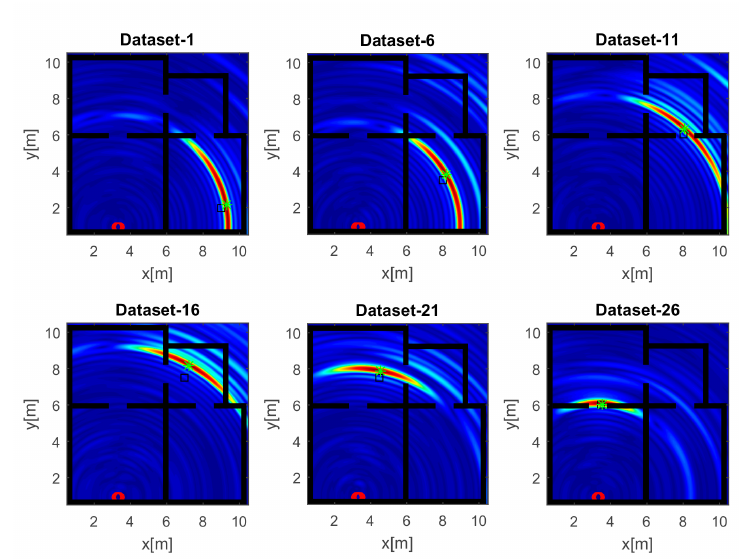
Figure 7. Tomographic images of a UWB source achieved with the horizontal array (A). Array (red circles); true source position (black square); estimated source position (green asterisk). Color scale is [0, 1].